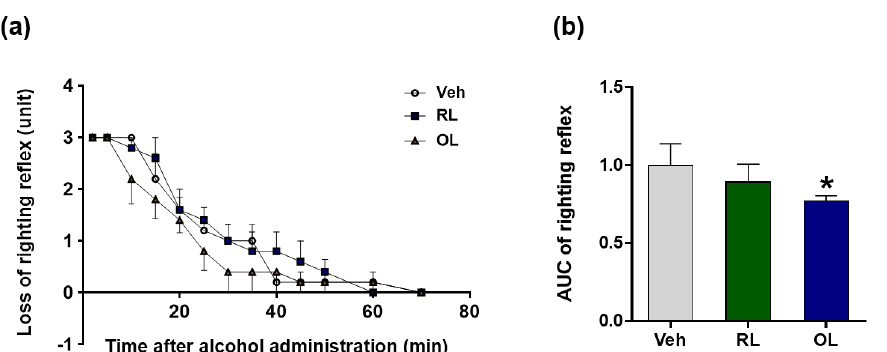
Figure 2. Effect of two extracts, raw leaves (RL) and oxidation-treated leaves (OL), on alcohol tolerance time following acute ethanol-loading in mice. Mice were treated with water (Veh), RL, or OL 1 h before injection of 4.5 g/kg ethanol ( n = 6, respectively). Loss of stereotactic reflexes was monitored for 80 min, scores of behavioral changes were plotted over time ( a ), and the area under the curve (AUC) was calculated ( b ). Data are presented as the means ± SEM. * p < 0.05 versus control.